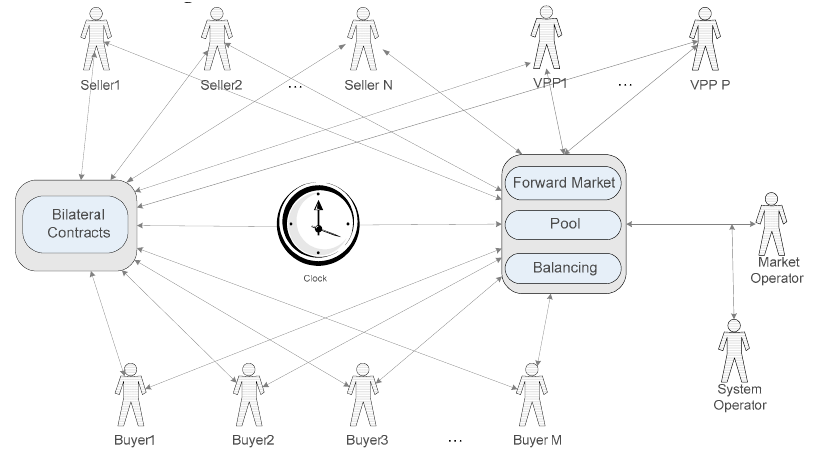
Figure 7. MASCEM negotiation framework [30].